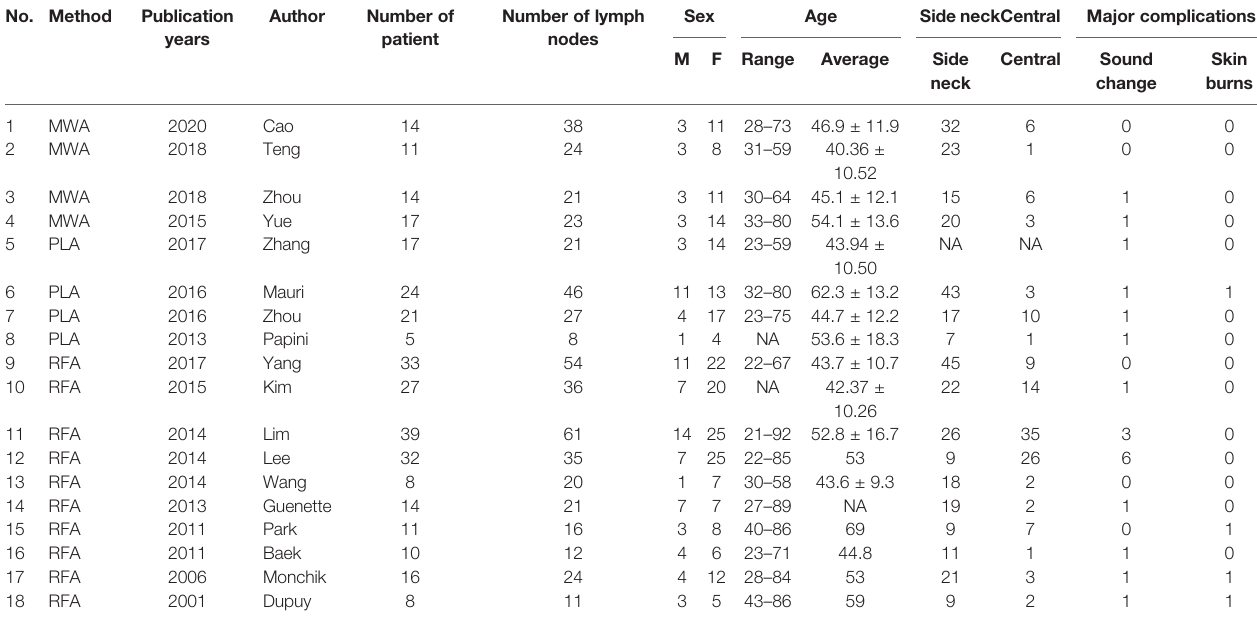
TABLE 3 | General patient information data and related clinical data.